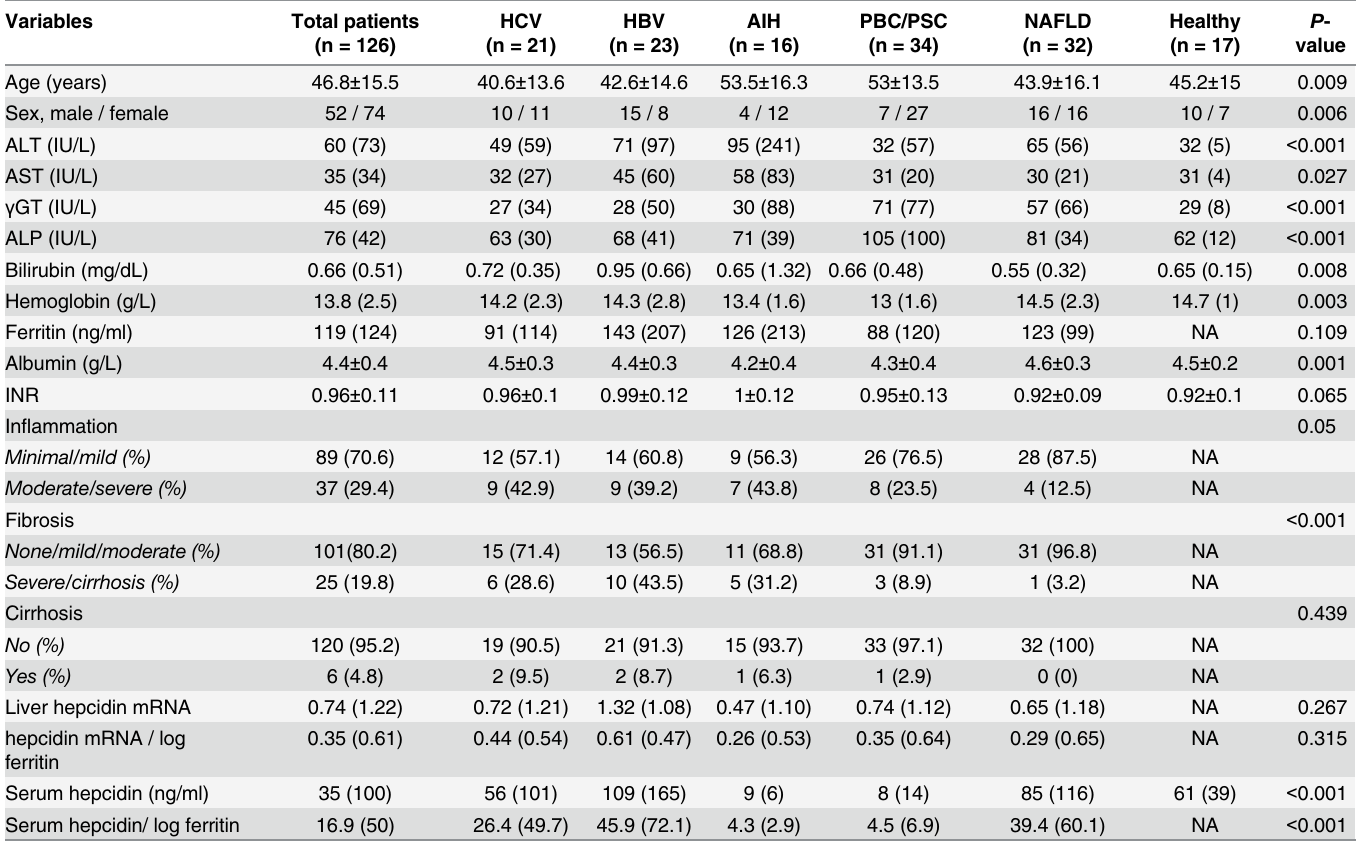
Table 1. The sera of seventeen volunteer blood donors [10 males, 7 females; age (mean ± SD) 45.18 ± 15 years] collected at first blood donation were used for serum hepcidin analysis as healthy controls. Table 1. Demographic, clinical, laboratory and histological data as well as hepatic hepcidin mRNA and serum hepcidin levels of patients and healthy controls.